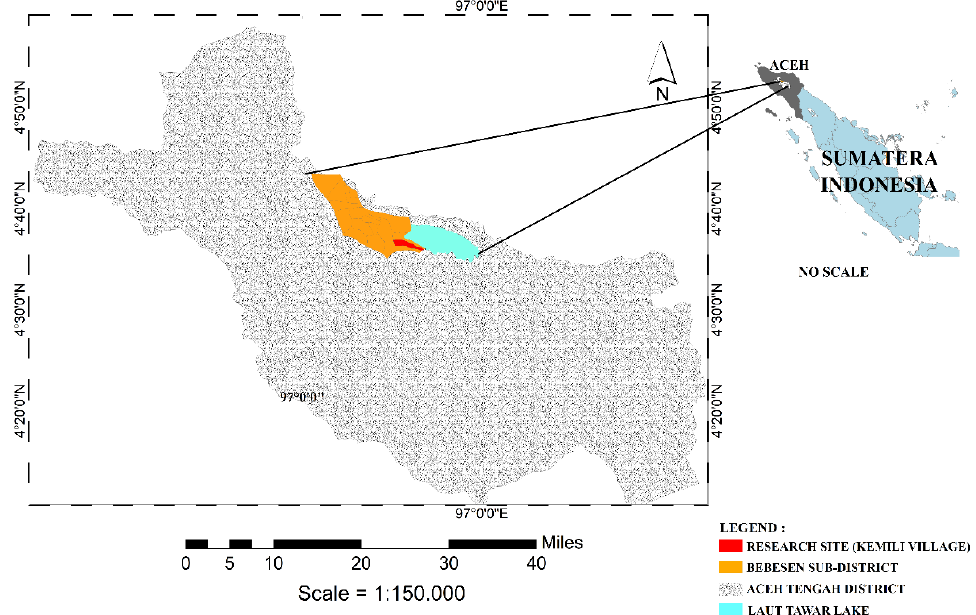
Figure 2. Area overview with a zoomed-in area showing the research location.